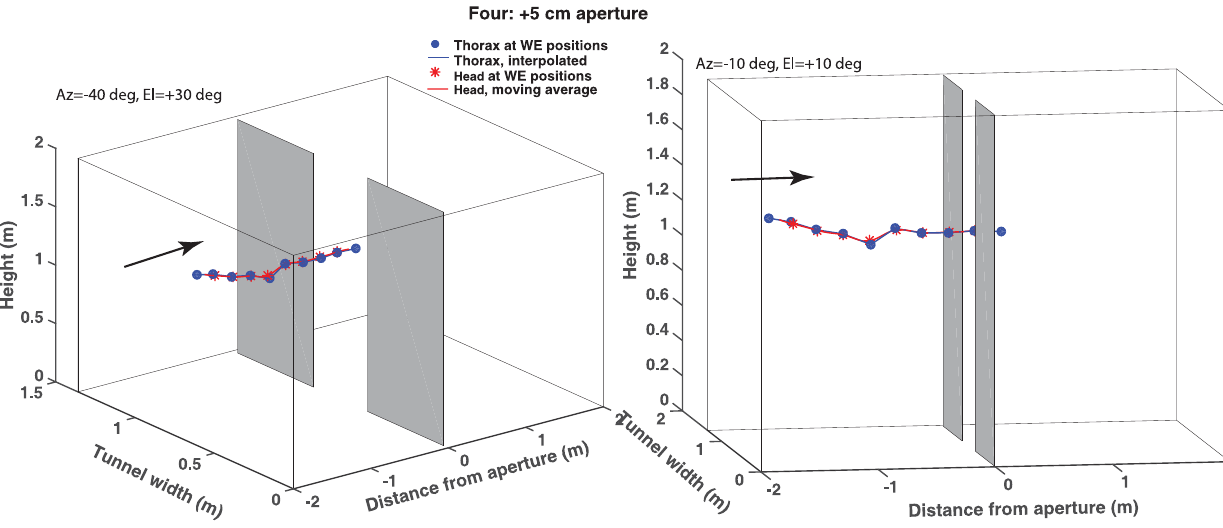
Fig 6. Two 3D views of the trajectory shown in Fig 5. Bird Four flies through an aperture that is 5 cm wider than its wingspan. The blue circles show the inferred position of the thorax at the time of each wing extension, the blue lines show the linearly interpolated thorax positions between successive wing extensions, and the red asterisks show the head position at the time of each wing extension. The image coordinates of the head, which were digitized in every video frame, were used to calculate the 3D trajectory of the head in every frame, as described in the text. The red curve shows the resulting 3D trajectory of the head during the entire video sequence, after smoothing by a 9-point centered rectangular moving average filter. Left panel: View from -40 deg azimuth, 30 deg elevation. Right panel: Near-lateral view from -10 deg azimuth, 10 deg elevation.